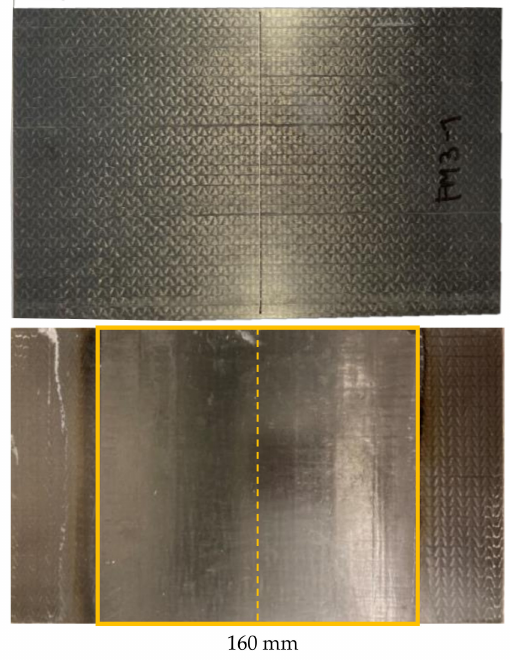
Figure 5. Exemplary damaged CFRP plate ( top ) using CNC milling and a ‘patch-repair’ CFRP plate (250 mm × 150 mm) with a UD patch after re-infiltrating ( bottom